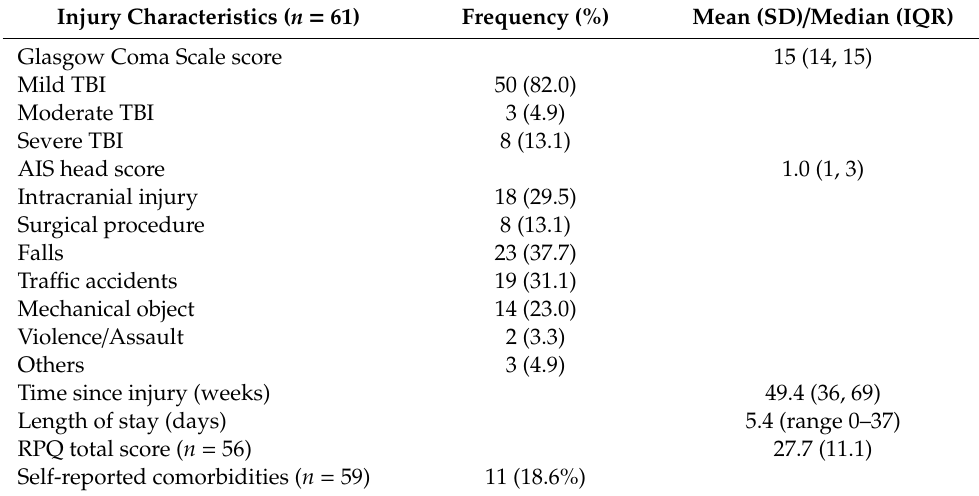
Table 2. Injury characteristics.